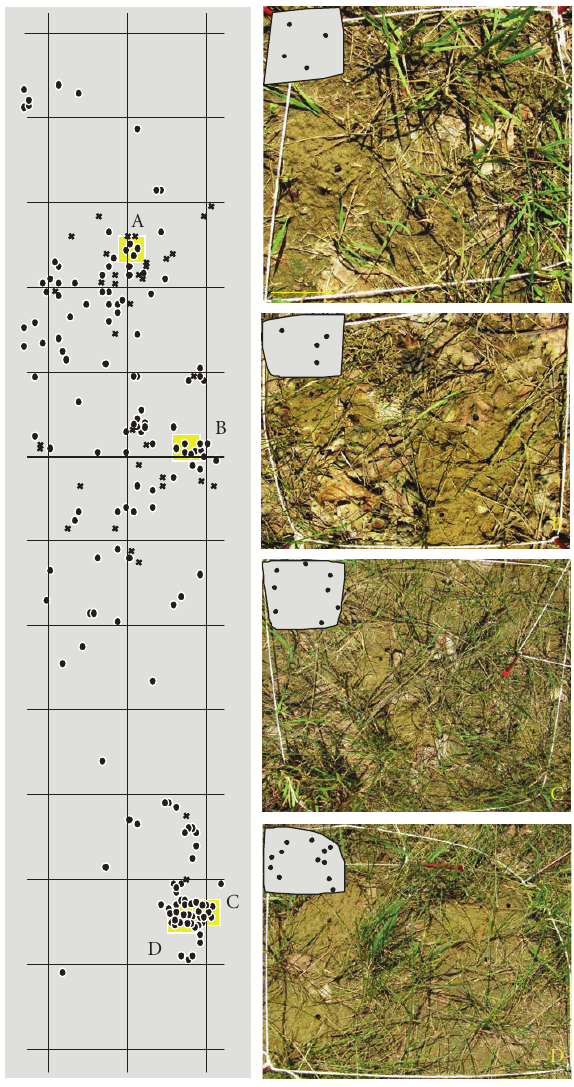
Figure 3: Mapping of the nests of Halictus scabiosae at the study site. Left: strip of 5 × 24m (see Figure 2) with the four batches of nests (A–D, marked by yellow areas) where the activities of Halictus scabiosae and their parasites were videotaped. The grid indicates 2m × 2m. Right: batches of active nests; the insets show the batches on a smaller scale with the nest entrances shown as black full